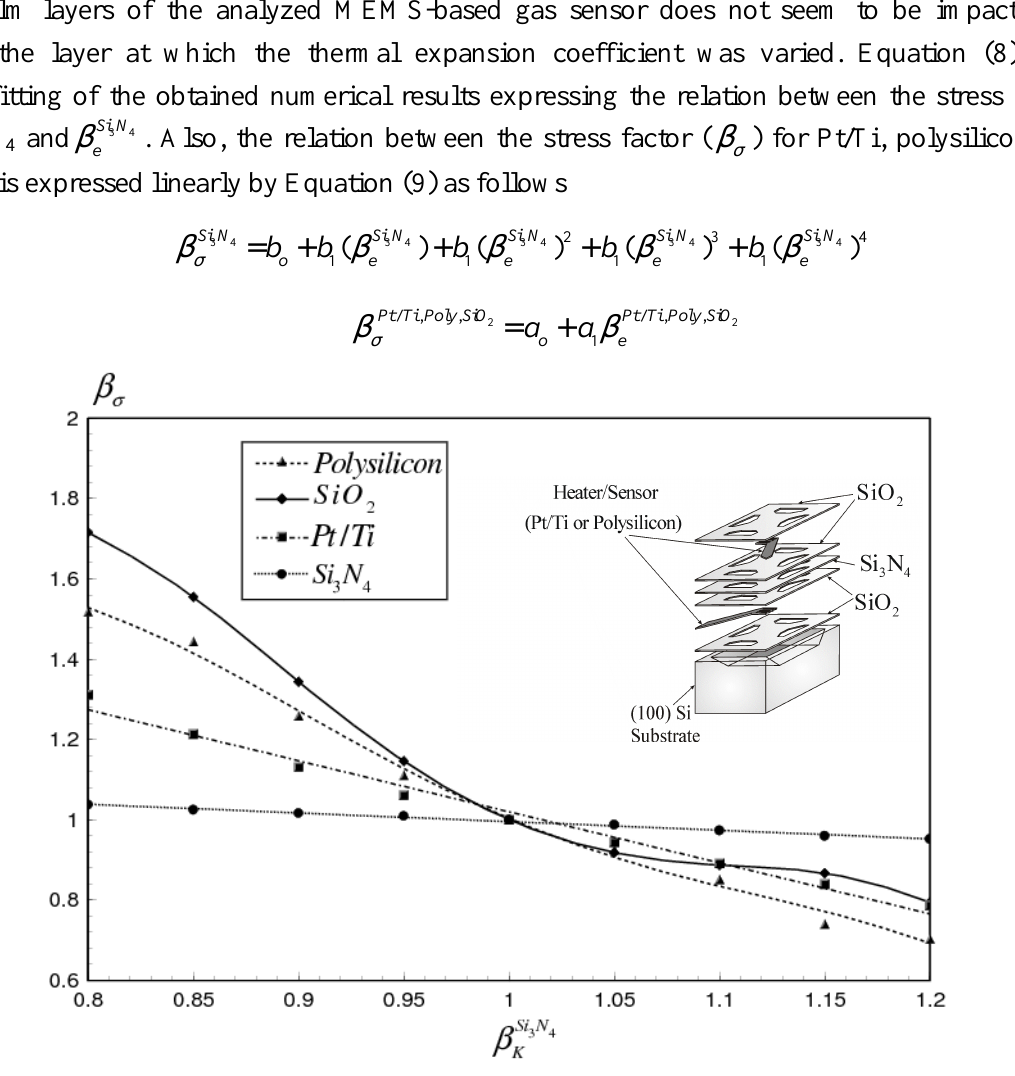
N on the maximum thermal stress of 3 4